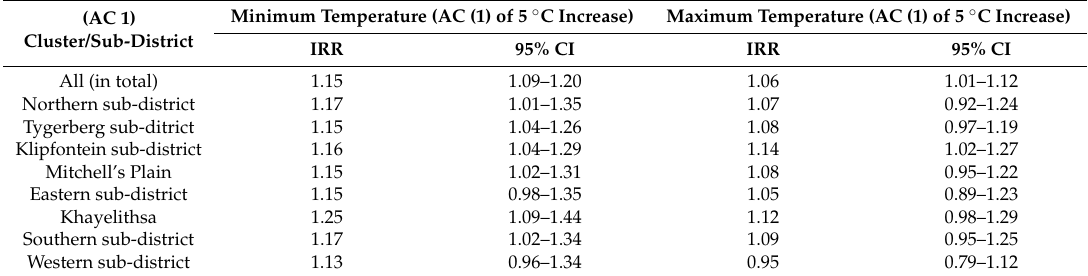
Table 4. Effect of 5 ◦ C increase in minimum and maximum temperature with a one-week